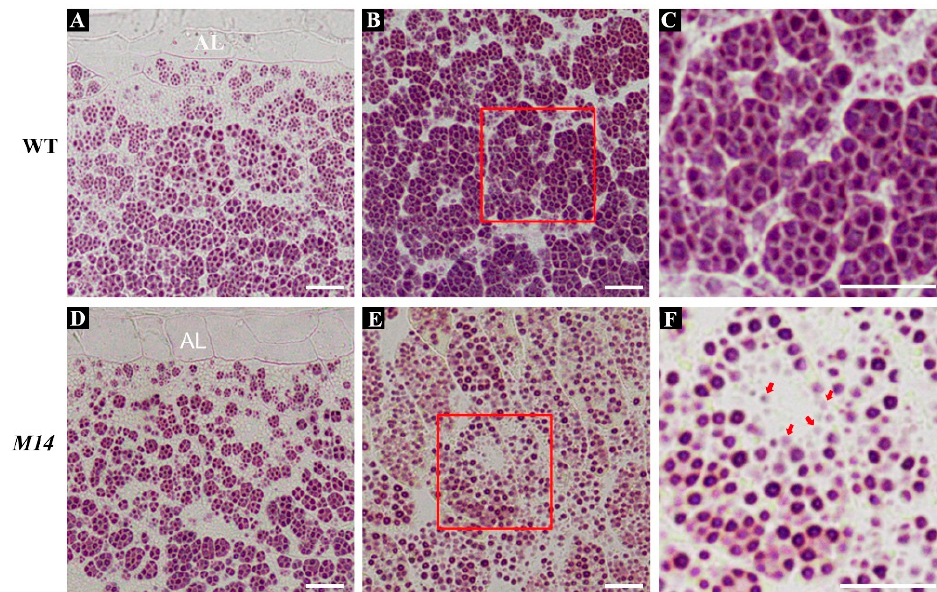
Figure 2. The formation of abnormal compound starch granules in M14 endosperm. ( A – F ) Semi-thin sections of WT ( A – C ) and M14 ( D – F ) kernels at 9 DAF are stained with I 2 -KI. ( A , D ) and ( B , E ) represent the outer and inner of endosperm, respectively. ( C , F ) represent the magnified region indicated by red outline in WT and M14 endosperm, respectively. Red arrowheads in ( F ) indicate abnormal weakly stained starch granules. AL, aleurone layer. Bars = 20 μ m.